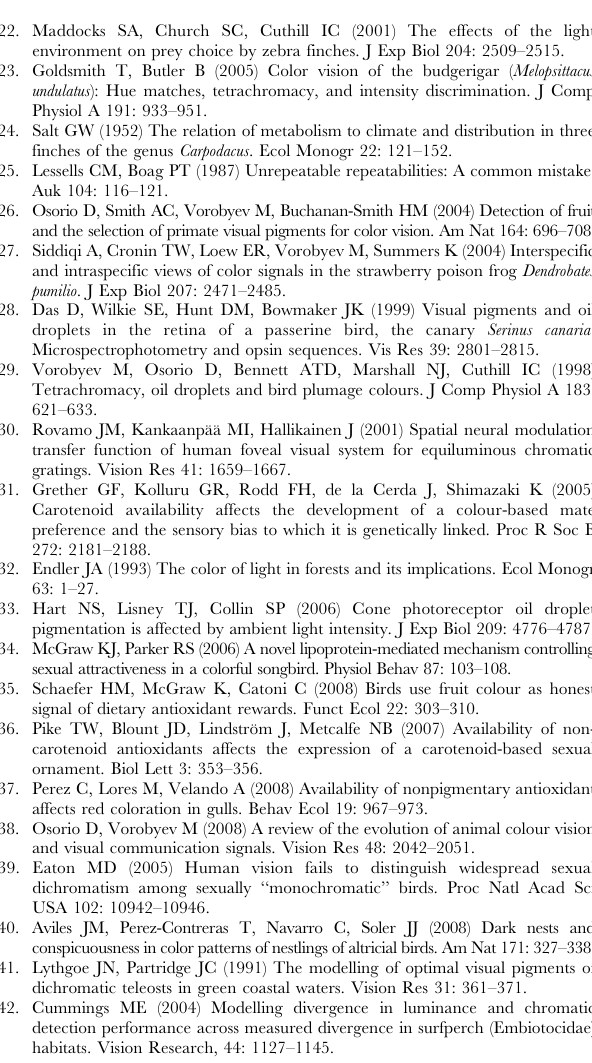
Figure S1 Images of experimental food and lighting conditions. (A) A sample image of the red food pellets